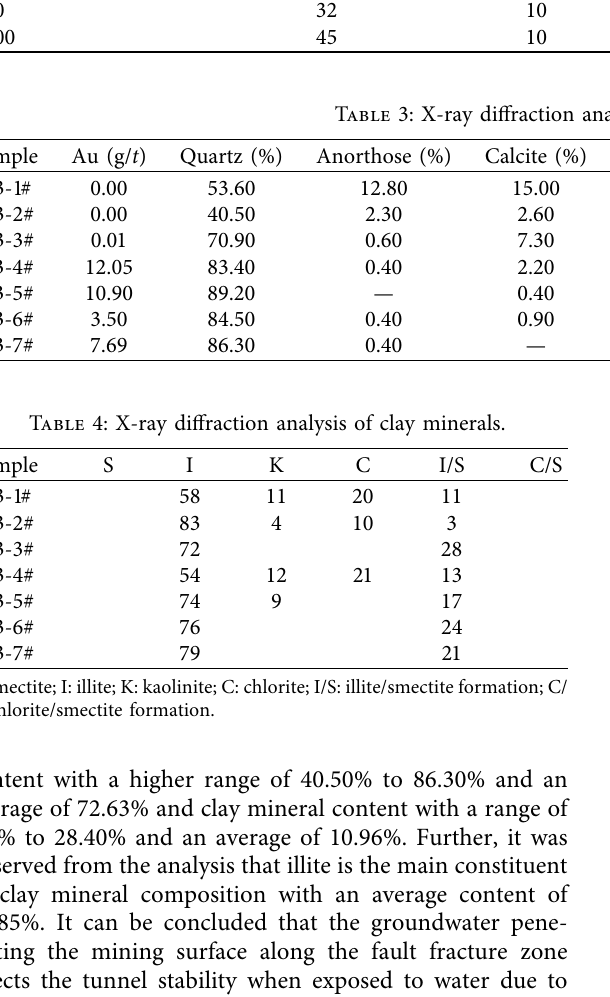
Depth below surface (m)